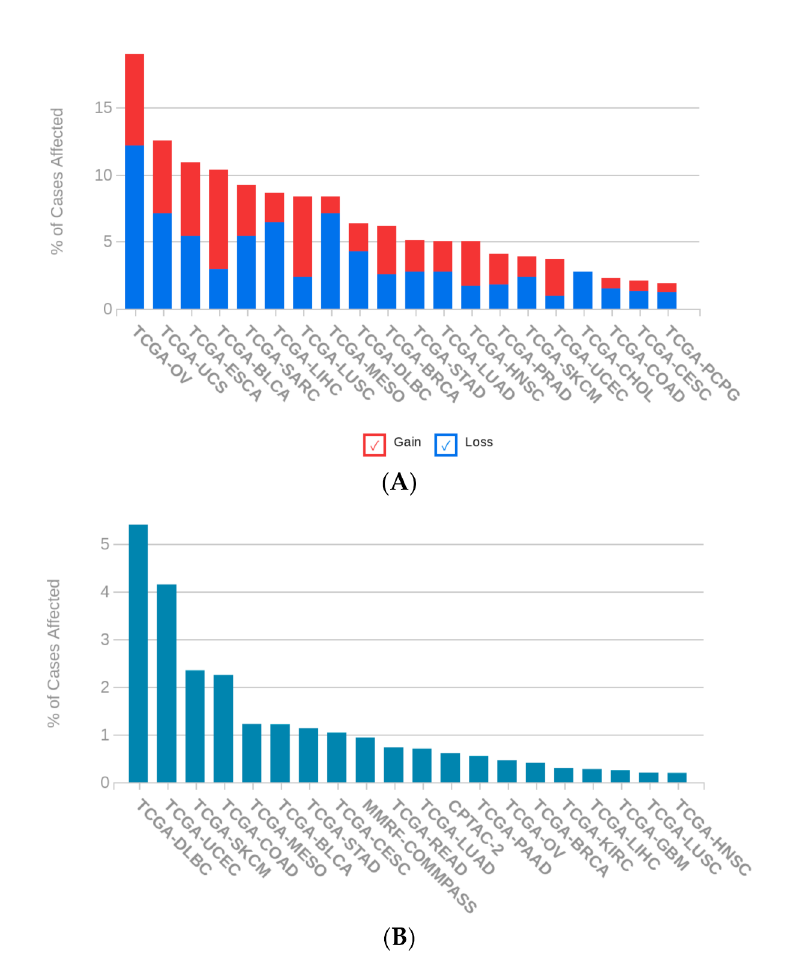
Figure A4. CNV and mutation distribution of PD1 (SNCA) in different cancer types. ( A ) CNV distribution. ( B ) Mutation distribution.